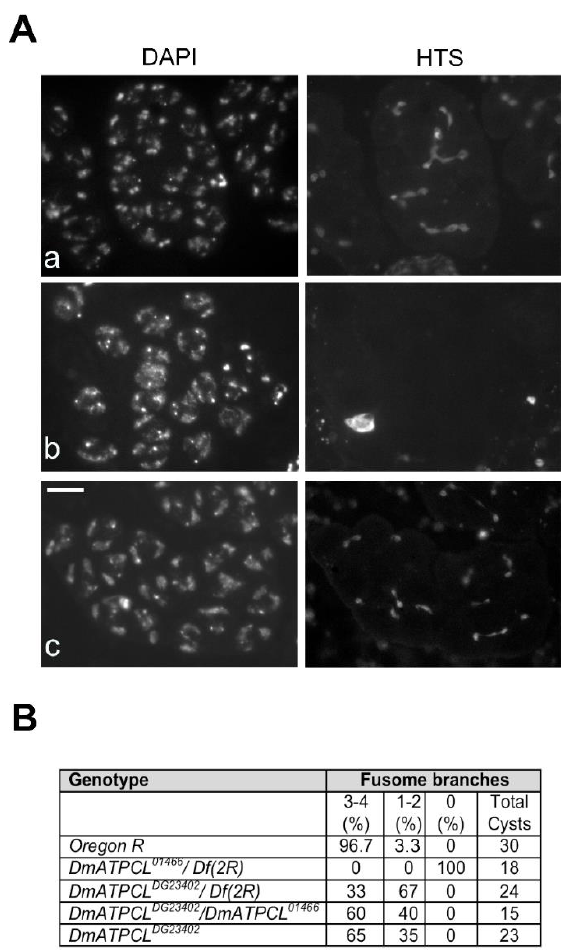
Figure 3. DmATPCL is required for fusome assembly. Hts localization in control (OR) and DmATPCL mutant primary spermatocyte cysts. Note that while the fusome elongates and extends clonally towards related germ cells in a wild-type cyst, giving rise to an evident branched structure ( Aa ), DmATPCL 01466 / Df(2R) mutant primary spermatocyte cysts are devoid of fusome ( Ab ) and DmATPCL DG23402 / DmATPCL 01466 cysts display a drastically reduced branching ( Ac ). Note that cysts devoid of fusome, Hts accumulates in distinct and large aggregates. Bar = 10 µ m. ( B ) Frequency of mutant cysts showing defective branching of fusome. Percentages refer to S3–S4 (apolar) primary spermatocyte-containing cysts showing the indicated number of fusome branches. Df(2R) = Df(2R)Exel7138.